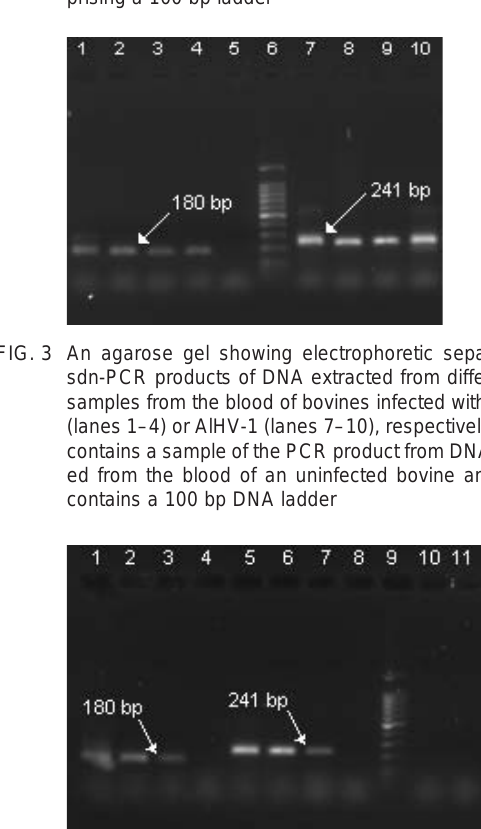
The sensitivity of the PCR was determined by per- forming sdn-PCR on a dilution range of total DNA extracted from a whole blood sample from bovines previously shown to be infected with OvHV-2 or AlHV-1. Five-fold dilutions were made and a 2 µ l sample from each was analysed in a 12.5 µ l reac- tion by PCR. The smallest amount of total DNA extracted from infected bovine blood from which a specific amplicon could be amplified was 1 ng (Fig. 4). the blood of bovines infected with OvHV-2 or AlHV-